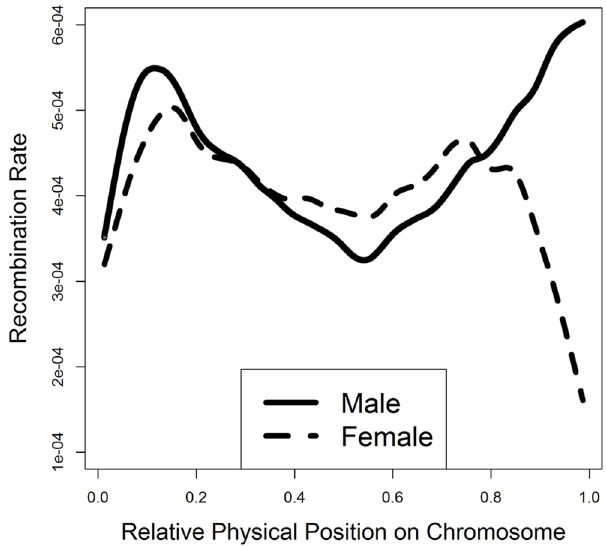
Fig 4. Smooth spline plotting of male and female recombination rates along a chromosome. The relative physical position for each SNP interval on a chromosome was calculated by standardizing the original physical position by the chromosome length: a value of zero corresponds to the beginning of a chromosome and a value of one corresponds to the end. The smooth spline model was fitted across all of the 29